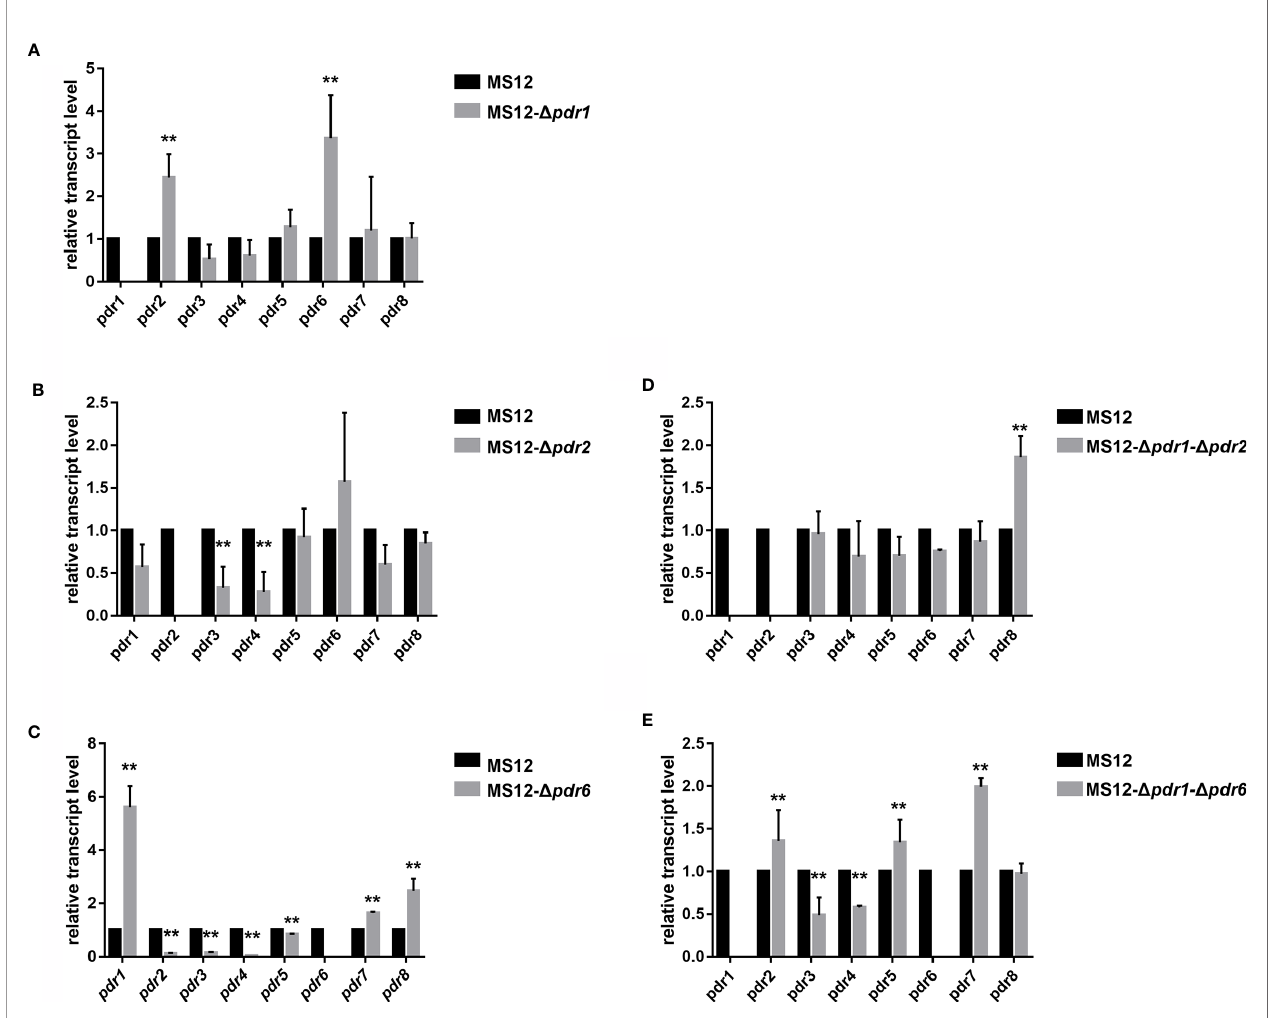
FIGURE 5 | Relative transcript levels of pdr genes in the MS12- D pdr1 /1 (A) , MS12- D pdr2 (B) , MS12- D pdr6 (C) MS12- D pdr1 - D pdr2 (D) and MS12- D pdr1 - D pdr6 (E) mutant compared to that in the original strain. Transcript level of each gene measured in the strain MS12 (black column) was taken as 1. The presented values are averages of three independent experiments (error bars indicate standard deviation). For RNA extraction, fungal strains were cultivated on YNB for two days at 25°C. Relative transcript levels signi fi cantly different from the value taken as 1 according to the paired t -test are indicated with * or ** (* p < 0.05, ** p <